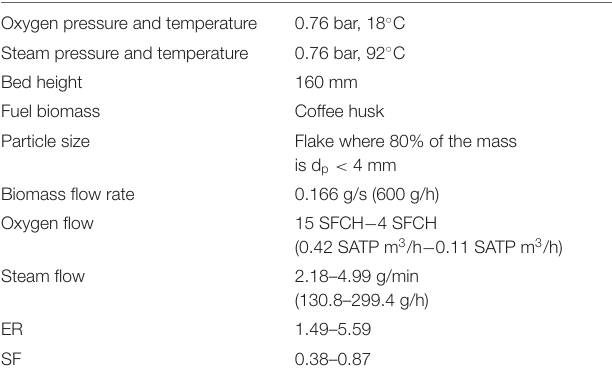
TABLE 2 | Experimental